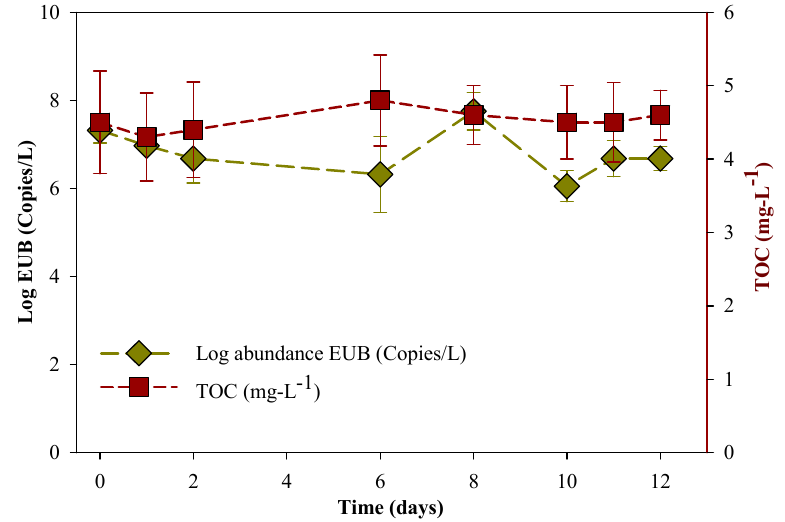
Figure 3. Evolution of the total bacteria gene abundance and total organic carbon (TOC) in HLPL water samples, with the initial MC ‐ LR concentration = 0.55 μ g ∙ L − 1 . The error bars represent one standard deviation for three measurements.